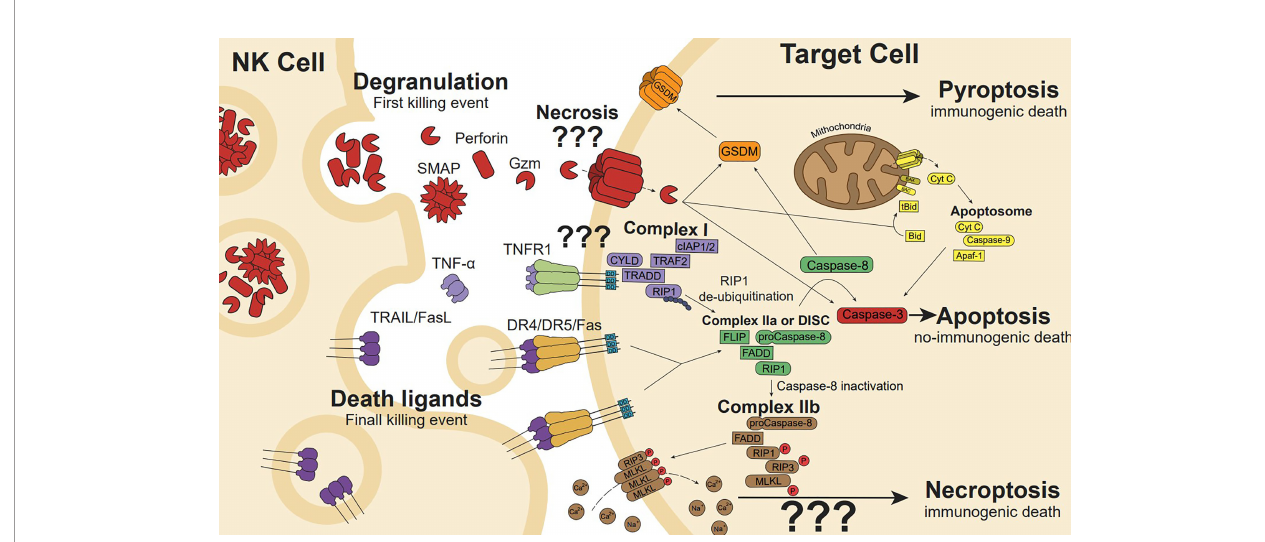
FIGURE 3 | NK cell cytotoxicity is mediated by the release of cytotoxic granules and death ligands. Cytotoxic granules secretion containing perforin induces pore formation, allowing internalization of granzyme (gzm). Gzm initiates apoptosis cleaving intracellular substrates such as effectors caspase-3 and caspase-7. In addition, gzmB can cleave the BH3-only protein Bid to generate the truncated t-Bid or the anti-apoptotic protein Mcl-1 to release Bim initiating the mitochondria outer membrane permeabilization (a process known as MOMP), the release of cytochrome c and other proapoptotic factors promote the formation of the apoptosome, caspase 9 activation, and the full activation of caspase-3 and -7 to execute the apoptotic process. Gzms and Caspases can also cleave and activate gasdermins (GSDMs), linking apoptosis to pyroptosis or directly activating pyroptosis. Membrane or soluble death ligands (TNF- a , FasL and TRAIL) can induce cell death through their death receptor (TNFR1, Fas, and DR4/DR5, respectively). Ligand-receptor interaction generates receptor trimerization and its intracellular death domains clustering inducing Complex I (CYLD, TRAF2, cIAP1/2, TRADD, RIP1) formation in the case of TNFR1. RIP1 de-ubiquitination induces Complex IIa formation. However, Fas or TRAIL death ligands trimerization promotes the death-inducing signalling complex (DISC) formation, which is similar to Complex IIa in conformation and performance. In the DISC or Complex IIa, Caspase-8 auto-cleaves leading to apoptosis pathway (involving Bid and/or caspase-3), while caspase-8 inactivation induces Complex IIa transformation in IIb, which drives phosphorylated-RIP3 and MLKL ion pore-forming, resulting in ion disbalance and necroptosis cell